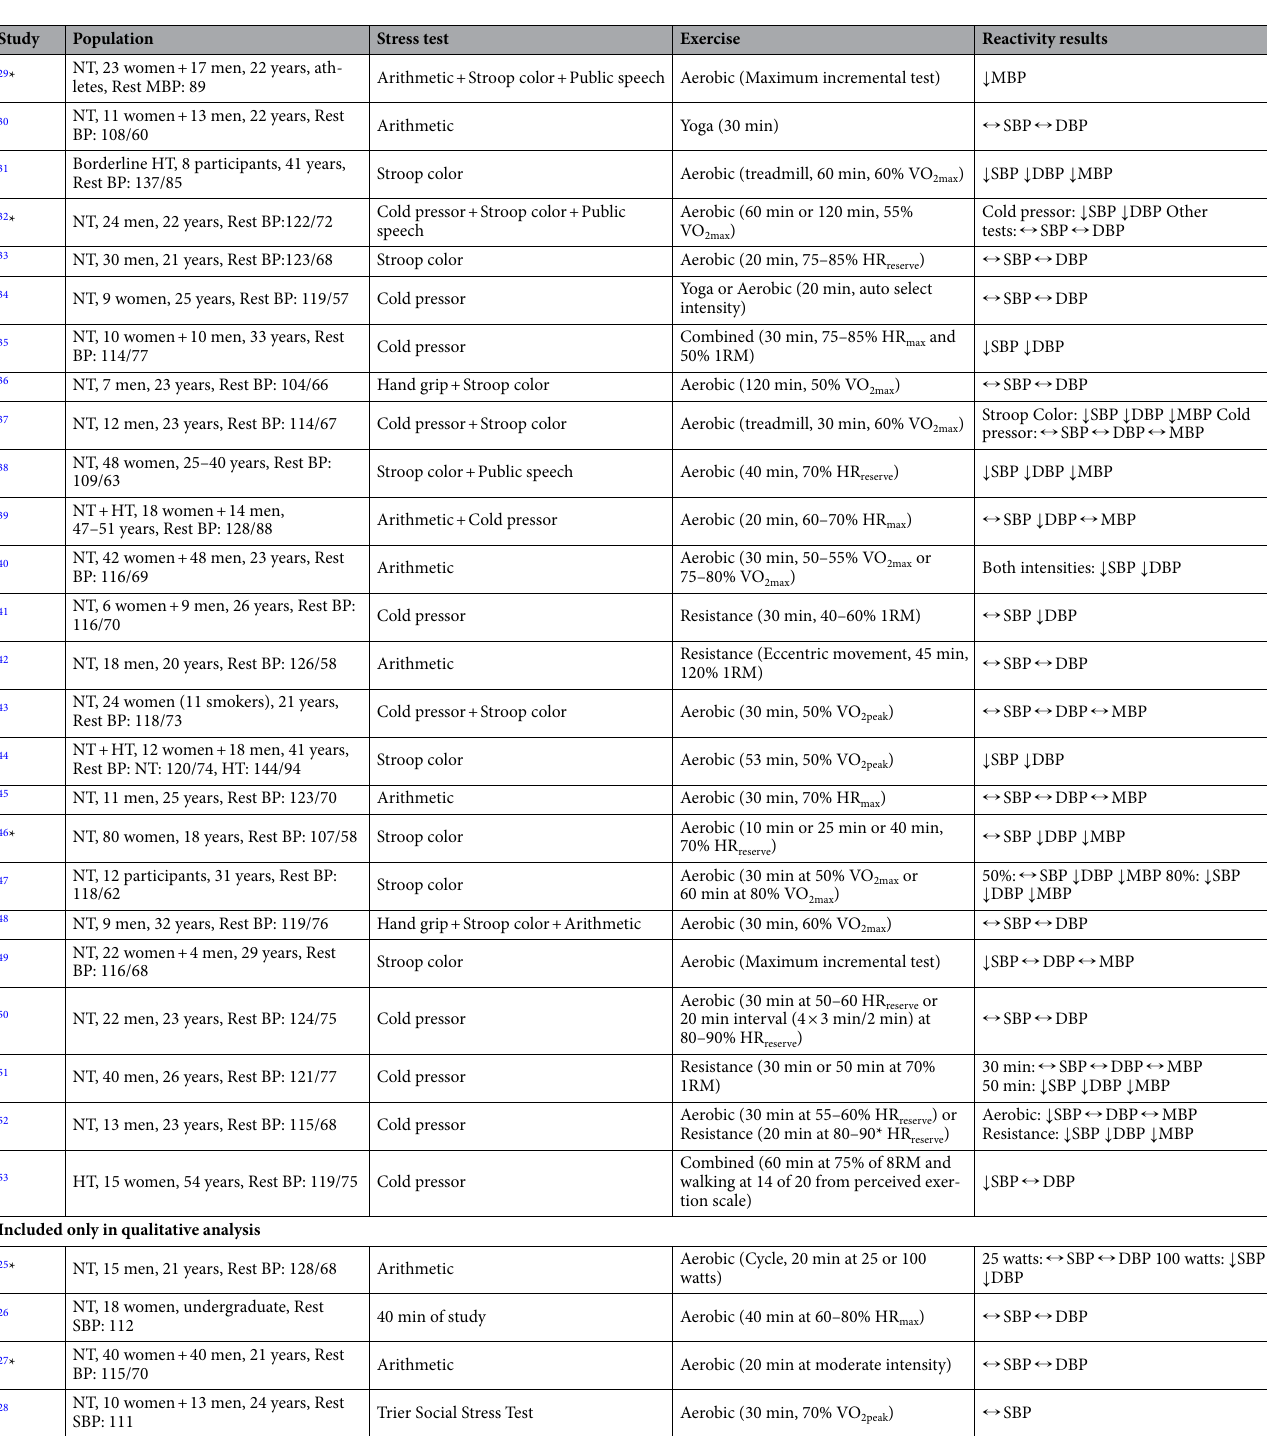
Table 1. Studies characteristics. The age refers to the average. SBP: systolic blood pressure; DBP: diastolic blood pressure; MBP: mean blood pressure; HR: heart rate; HT: hypertensives; NT: normotensives; *: randomized clinical trials, the other studies are cross over